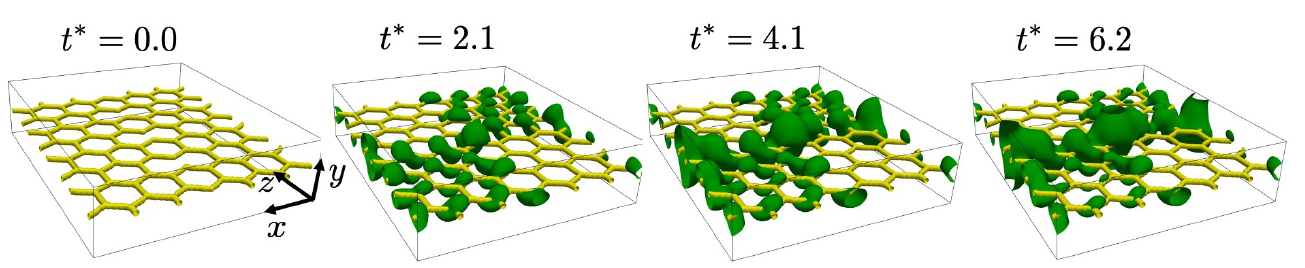
Figure 5. Solute segregation to low angle twist grain boundary as a hexagonal network of screw dislocations. Yellow indicated the dislocation lines, dark green is solute iso-surface of 0.4, and t 0 = 10 2 t c